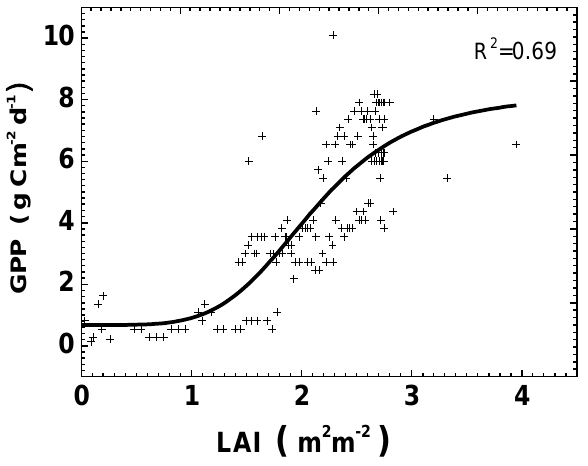
Fig. 6 The relationship of daily total gross primary production ( GPP ) and leaf area index ( LAI ). Fig. 6. The relationship of daily total gross primary production (GPP) and leaf area index (LAI). Data were obtained from the grow- Data were obtained from the growing period in 2005. ing period in 2005.